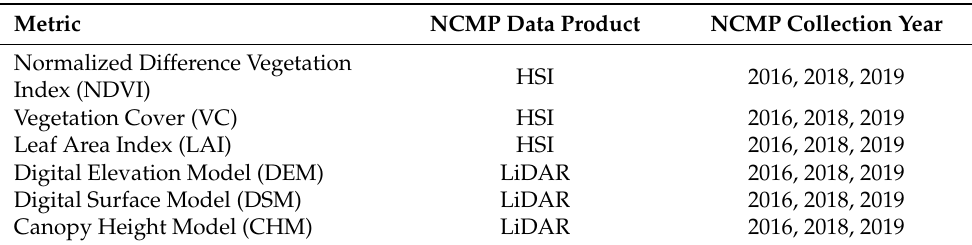
Table 2. Summary of dune vegetation metrics generated from the DuneVeg Toolbox used for con- ducting multi-temporal trend analysis. Included are National Coastal Mapping Program (NCMP) collection dates (year) used for each